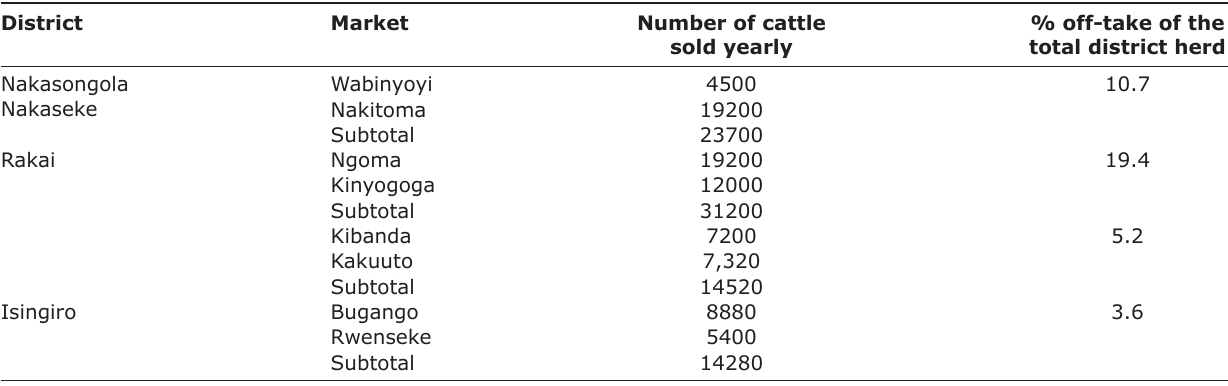
Table-14: Annual potential volume of cattle that can be sold per market and percentage off-take from two markets per district. District